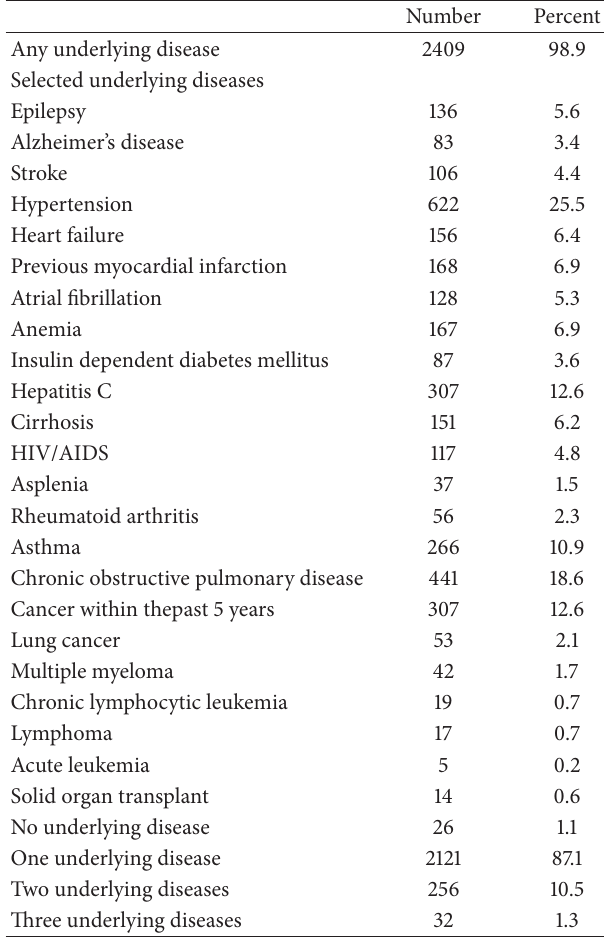
Table 2: Occupations of 581 patients with IPD compared with Alberta population 2015 working in these occupations.